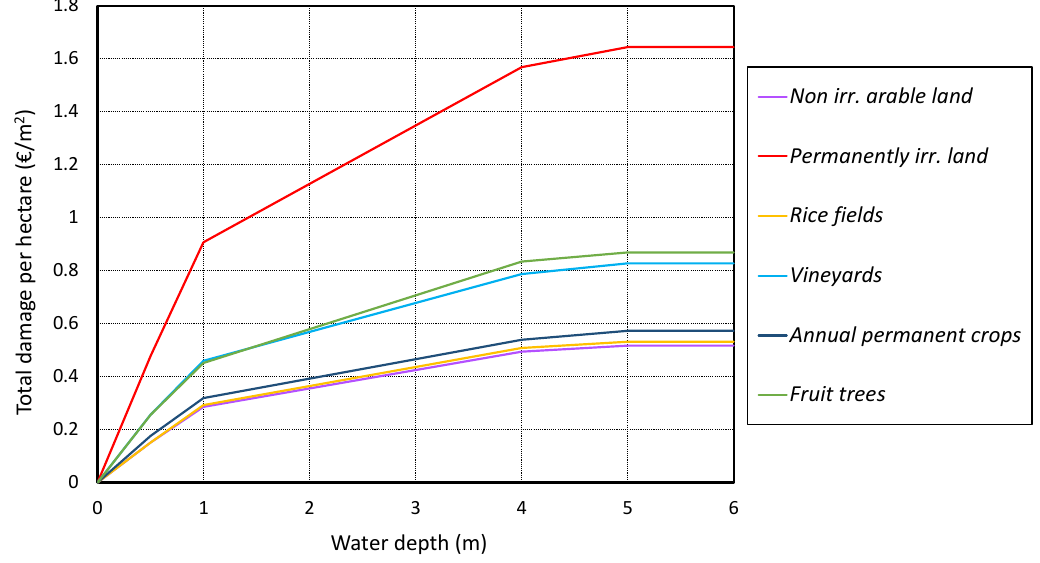
Figure 14. Damage curves for agricultural classes in Magazzolo floodplain.